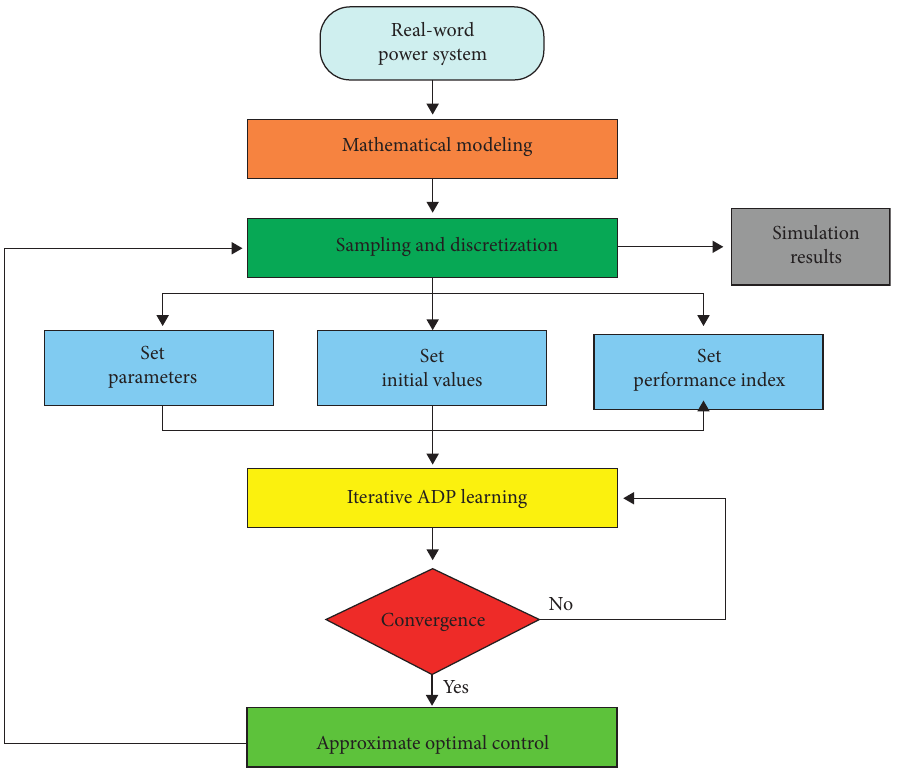
Figure 5: Application to the benchmark power system.